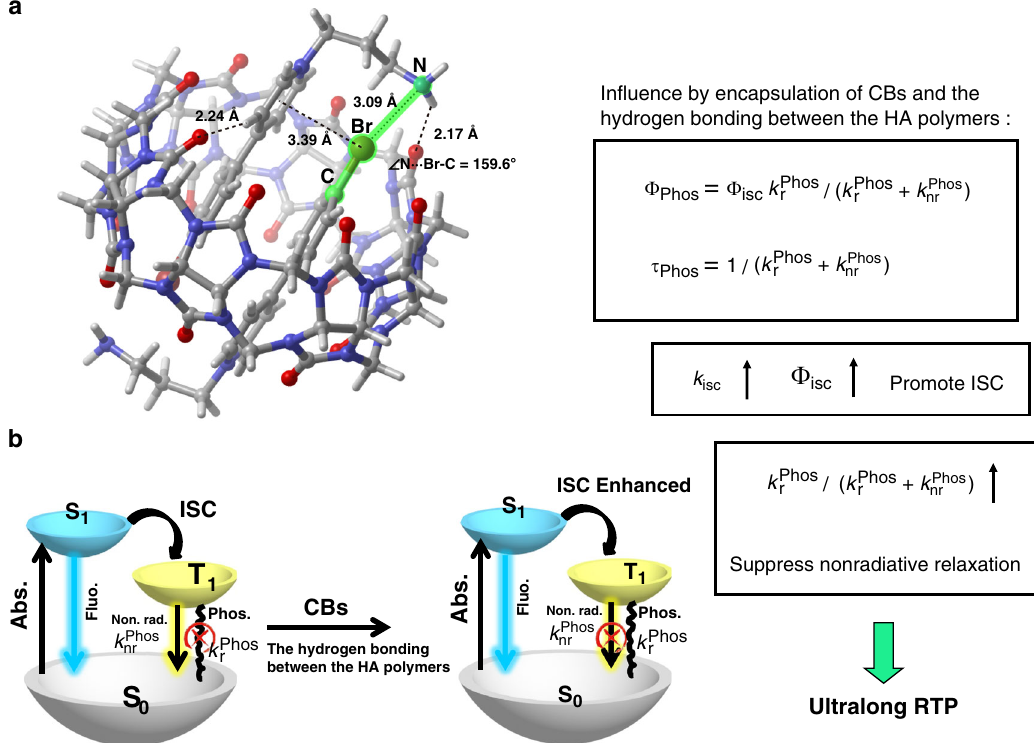
Fig. 5 Mechanism of CBs/HA – BrBP phosphorescence. a Structure of CB[8]/BrBP – NH 2 assembly as optimized by density functional theory calculations and b proposed mechanism of the long-lived RTP exhibited by this